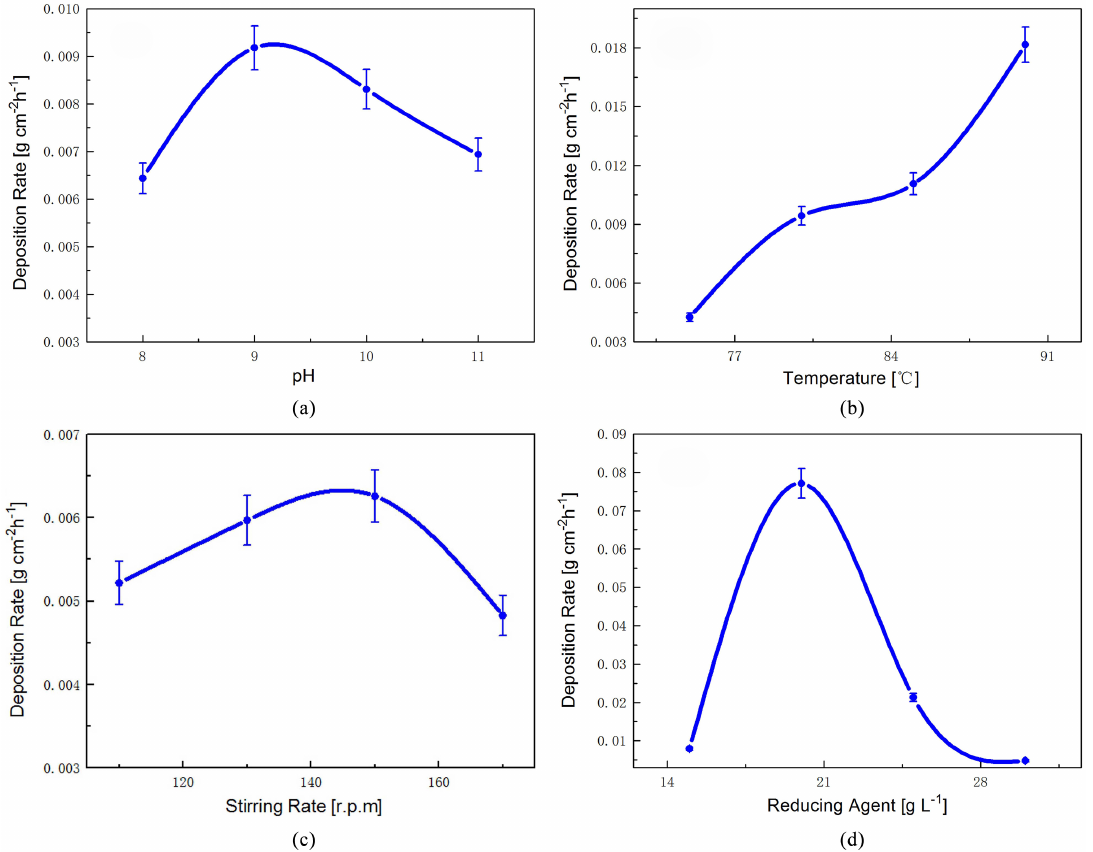
Figure 1. Effect of experimental parameters on deposition rate (a) pH, (b) temperature, (c) stirring rate, (d) concentration of reducing